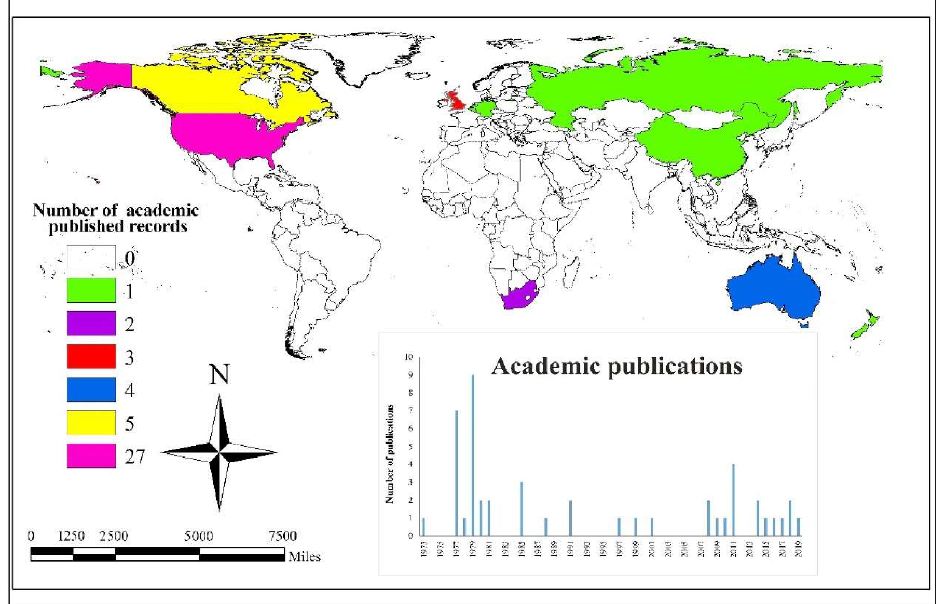
Figure 2. Global distribution and number of publications (1973–2019) on iceberg utilization as an unconventional water resource.